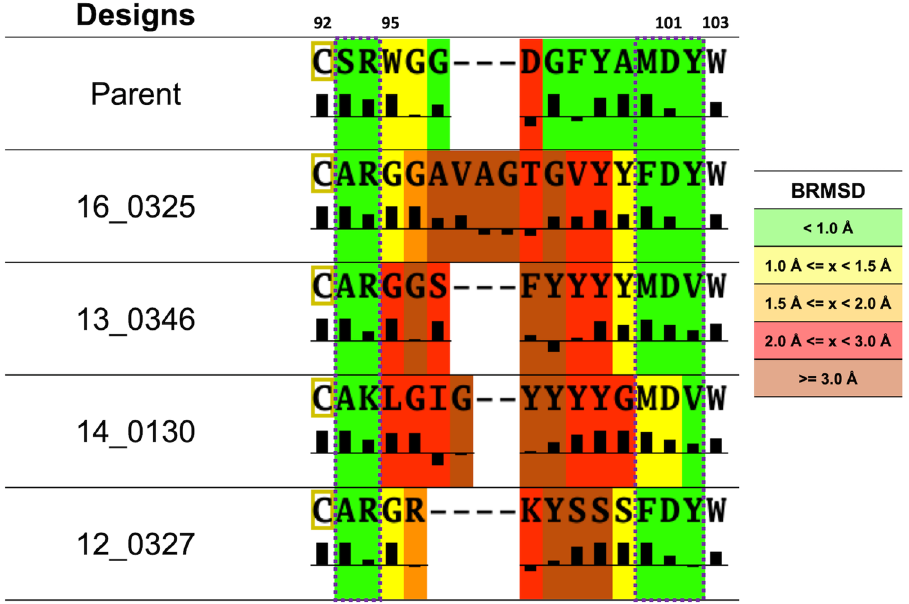
Figure 7. Structure prediction accuracy for the H3 designs versus surface accessibility. Backbone RMSD of the H3 loop between predicted designs and their crystal structures is highlighted by color ranges. Surface Accessibility as defined in MOE (Chemical Computing Group) is calculated using the crystal structure and is shown under each corresponding H3 loop sequence as histograms indicating the degree of burial. Positive bars indicate that a residue is buried. Dashed purple rectangles highlight H3 stem